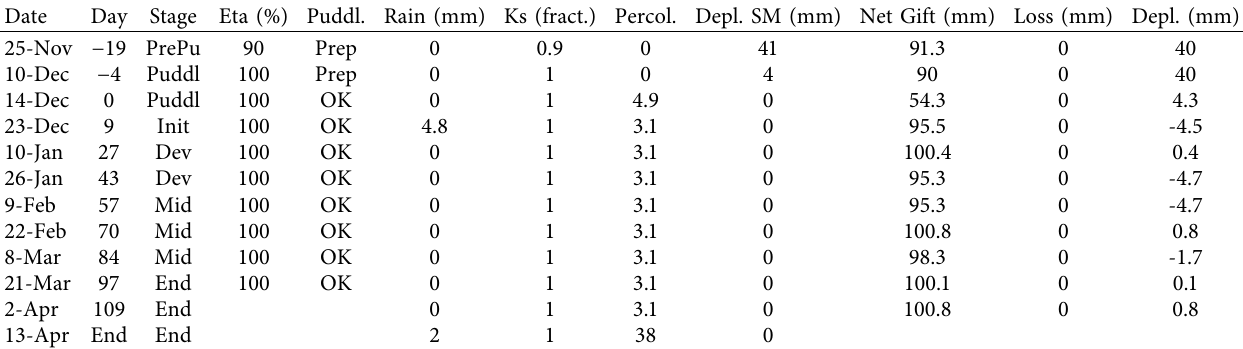
Table 12: Rice irrigation schedules, starting from the 25 th of November and ending on the 13th of April of the next year. Date